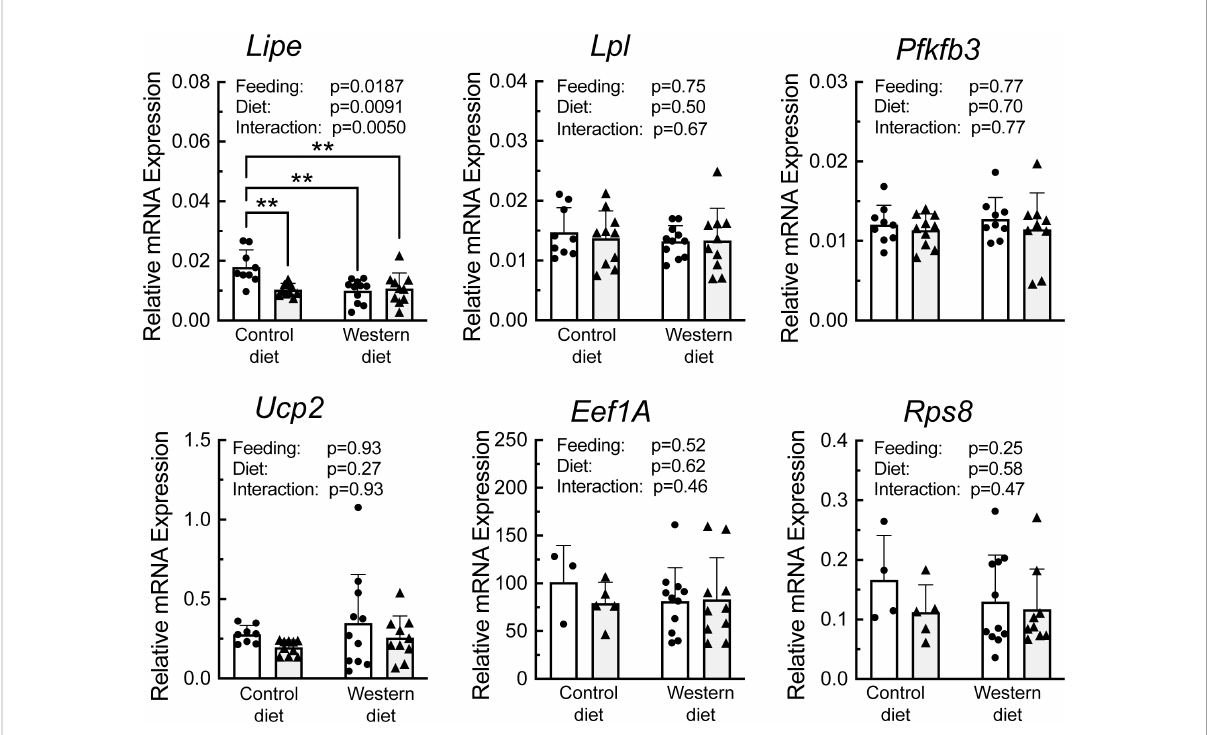
FIGURE 7 qRT-PCR analysis of mRNA abundance in the liver of rats fed a control diet or Western diet for 2 weeks. n=8-12 rats/group.